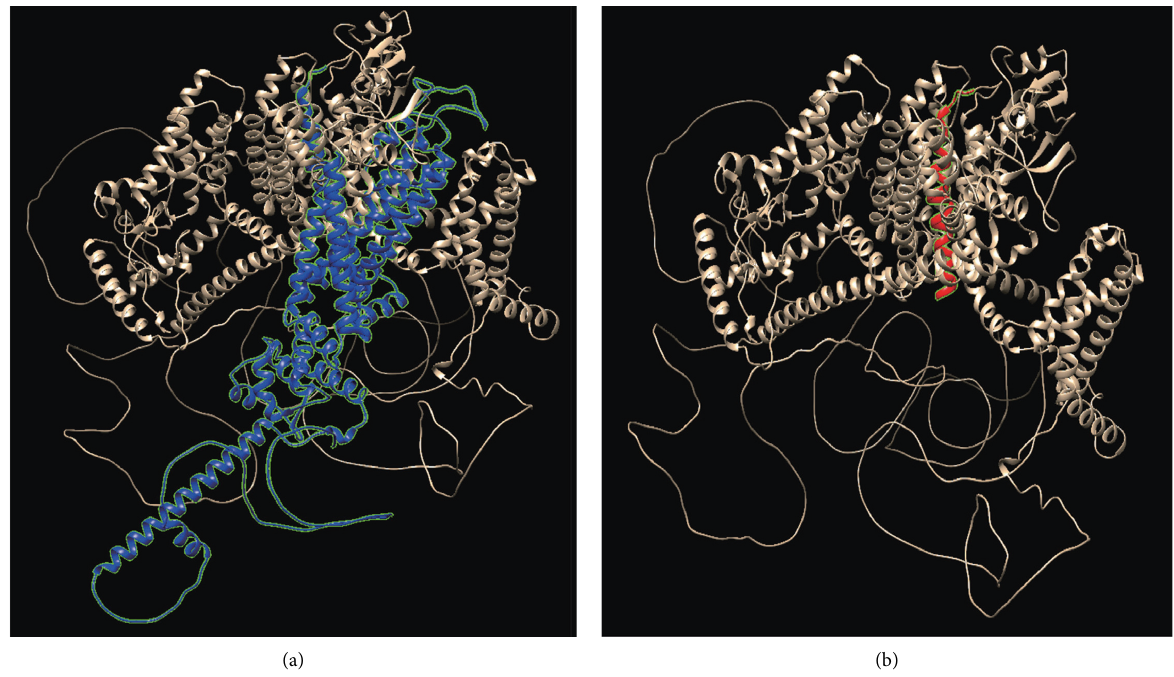
Figure 4: Tertiary structure of SCN5A WT and SCN5A c.4313dup (p.Trp1439ValfsTer32) mutant predicted using AlphaFold (https:// alphafold.ebi.ac.uk/entry/Q14524) and shown in UCSF Chimera. (a) The blue region in SCN5A WTindicates the frameshift region resulting in 577 amino acids’ deletion in p.Trp1439ValfsTer32 mutant. (b) The red region in SCN5A c.4313dup (p.Trp1439ValfsTer32) mutant (right) shows additional 32 amino acids caused by the